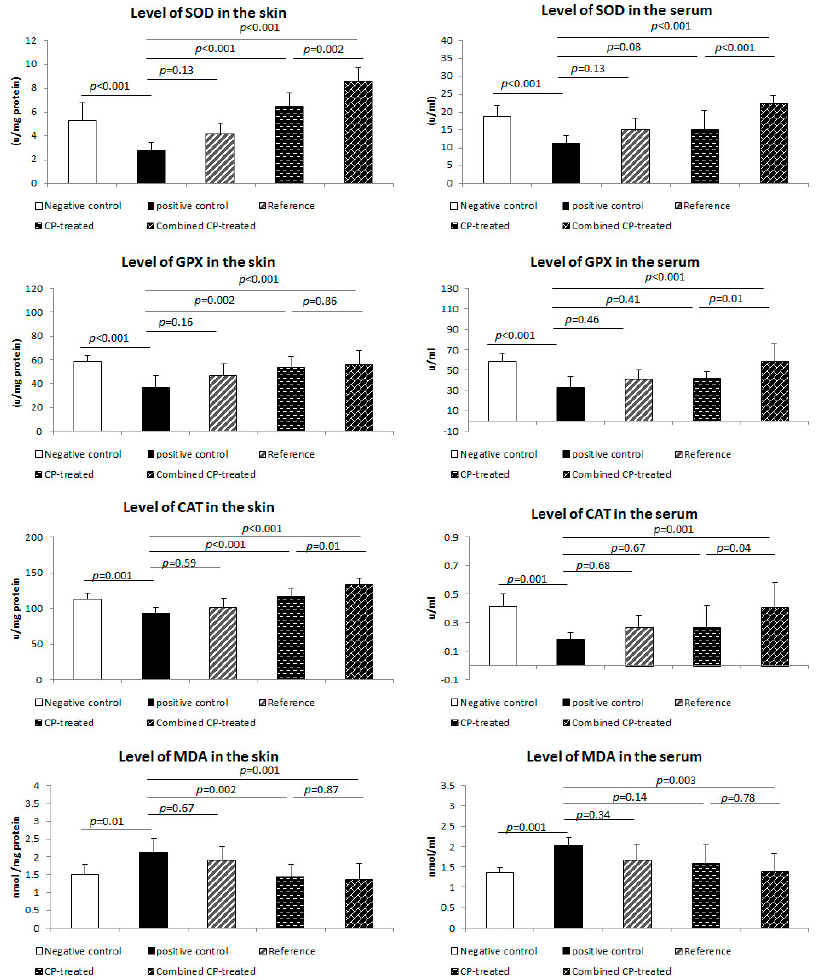
Figure 4. Effect of Cucurbita pepo L. (CP) on the oxidant/antioxidants profile of the study groups. Levels of SOD, GPX, CAT, and MDA in the skin wound were assessed using ELISA. Data are presented as the mean ± SD, n = 10. One way ANOVA test was used to compare between groups, followed by the Bonferroni post hoc test.